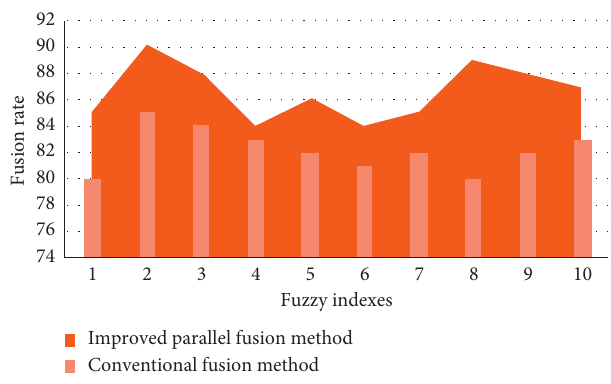
Figure 8: Fusion rate